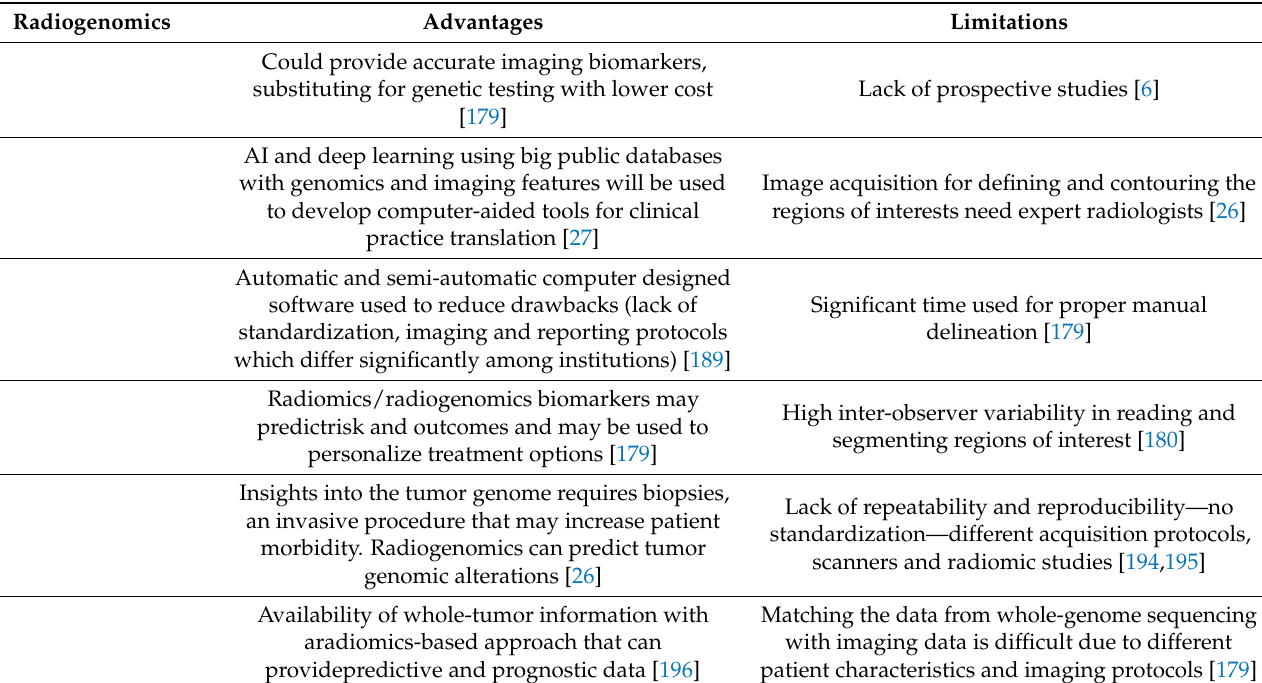
Table 5. Advantages and limitations of radiogenomics compared to actual management of PCa risk stratification.